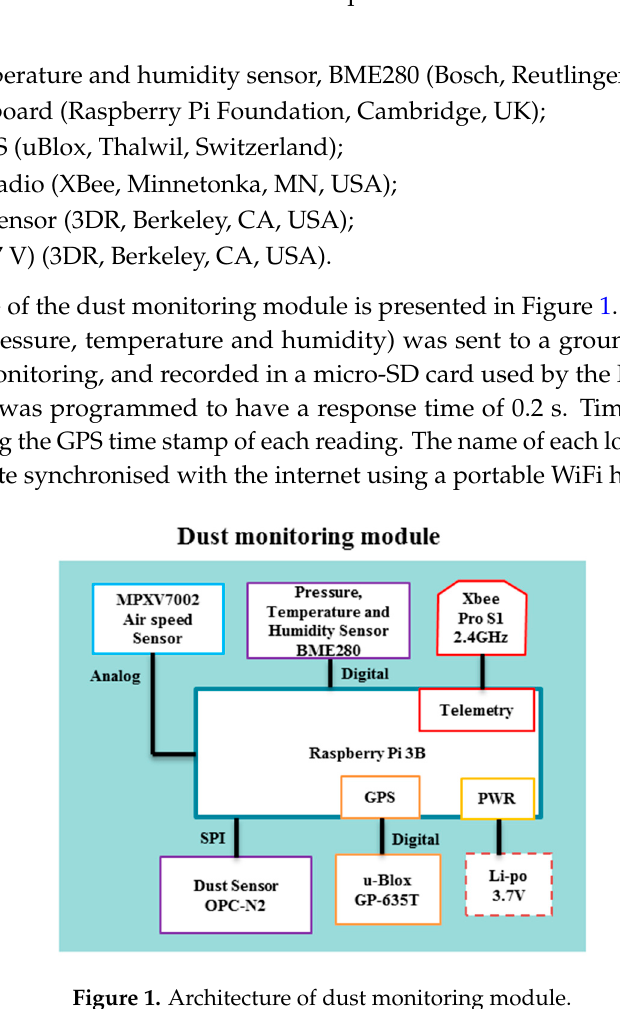
Figure 1. Architecture of dust monitoring module.